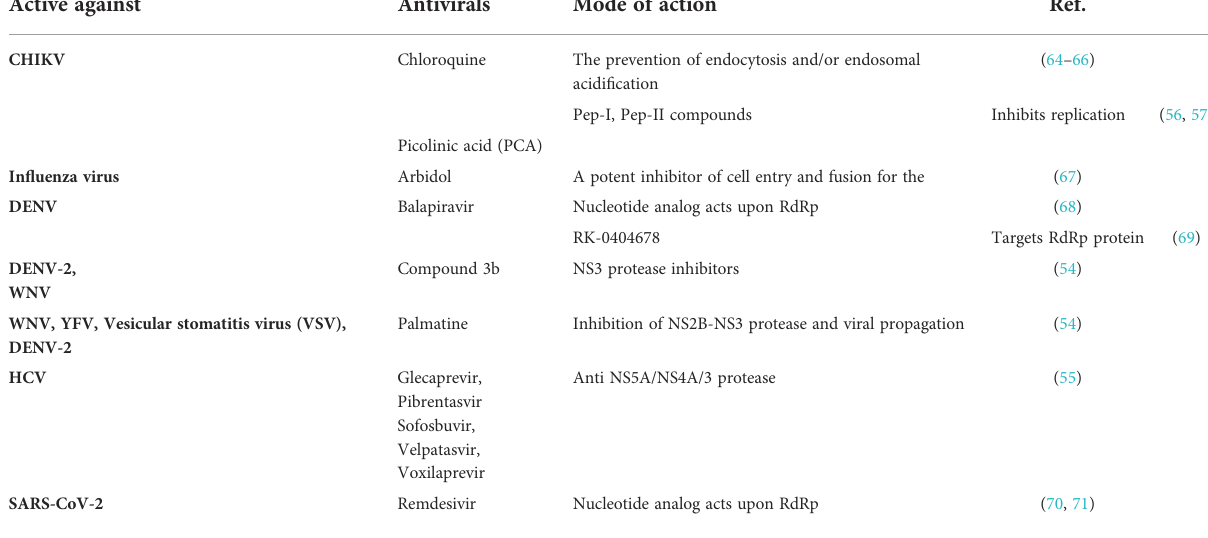
TABLE 2 List of DAA against